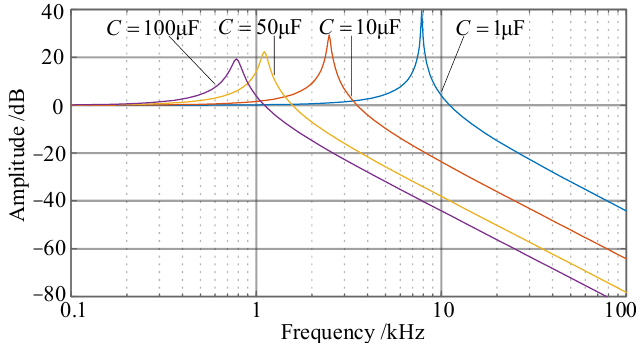
Figure 8. The Bode plot of G it2is ( s ) under different AC − filter capacitance.